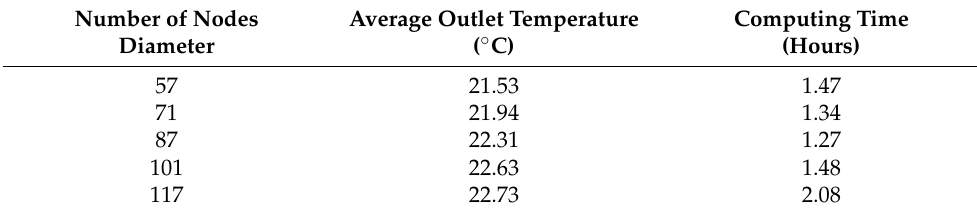
Table 3. Number of nodes and computation time.